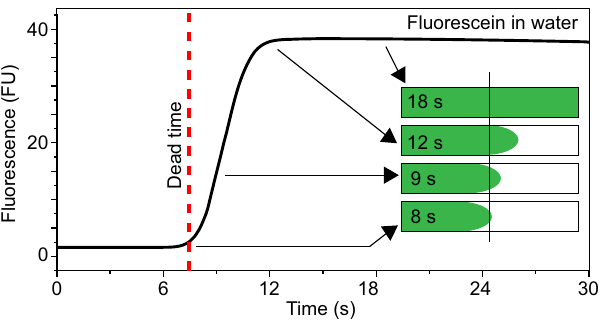
Fig. 7 Origin of sigmoidal traces in Cap fl ex. 1 nM Fluorescein in water is measured in Cap fl ex at 3500 mbar injection pressure. The dead time of the instrument is the time it takes for the solution front to reach the detector window (black line of the scheme in the inset). The dead time of ∼ 8 s is marked with a dashed red line in the actual data. The schematic depicts the progress of the solution front with time resulting in a sigmoidal increase of fl uorescence intensity, which reaches a stable baseline fl uorescence after 12 s when the solution front has completely crossed the detector window. Source data are provided as a Source Data fi